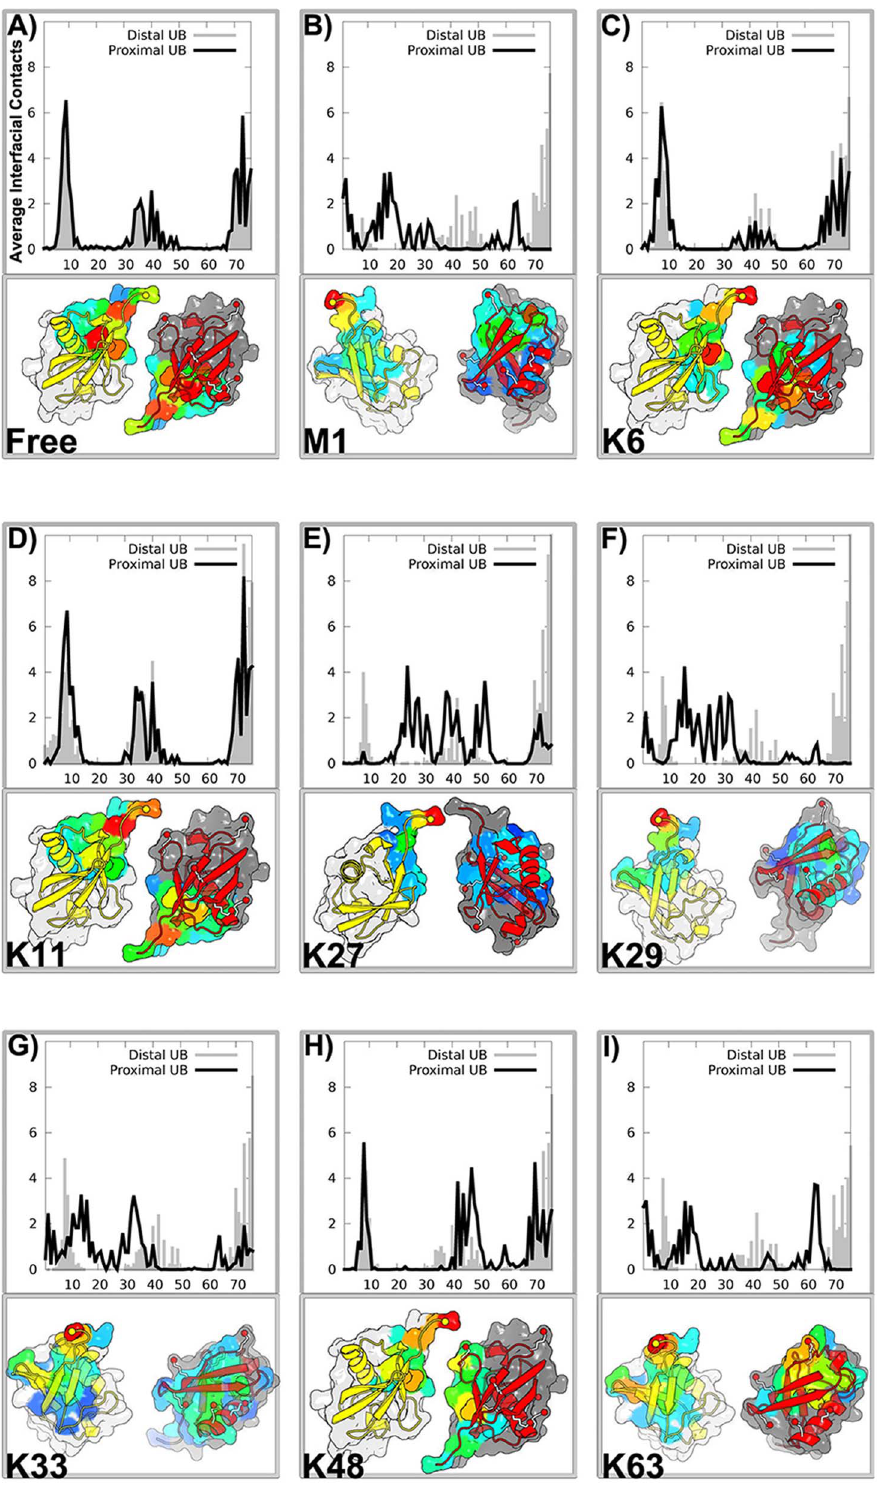
Figure 3. Symmetry of interfacial interactions present in the free model is broken in the linkage models. It shows the distribution of average interfacial contacts along the residue index of proximal Ub (black) and distal Ub (grey). The distribution was mapped onto the surface of two Ub monomers whose positions are artificial for better view of the binding surface. The distal unit is represented by light grey surface with yellow cartoon, while the proximal unit by dark grey surface with red cartoon. The ‘‘hot spot’’ residues taking part in the binding are highlighted by surface with colors from blue to red, corresponding to having low and high interfacial contacts, respectively. Note that the analysis was based on the conformations with R COM v 3.2 nm.